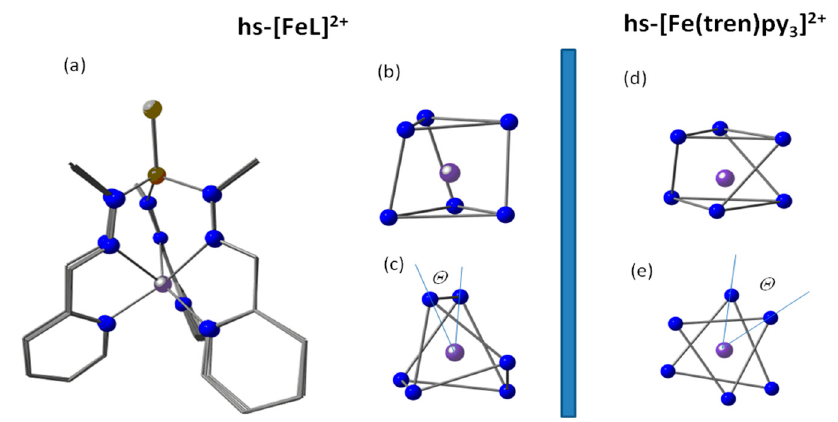
Figure 3. ( a ) Side view of the merged DFT-derived structures of hs-[FeL] 2+ ; ( b ) side view and ( c ) top view along S–P–Fe of the [FeN 6 ] coordination sphere (BP86-D/TZVPP); ( d , e ) show side and top view along of the [FeN 6 ] coordination sphere of hs-[Fe(tren)py 3 ] 2+ (BP86-D/TZVPP).